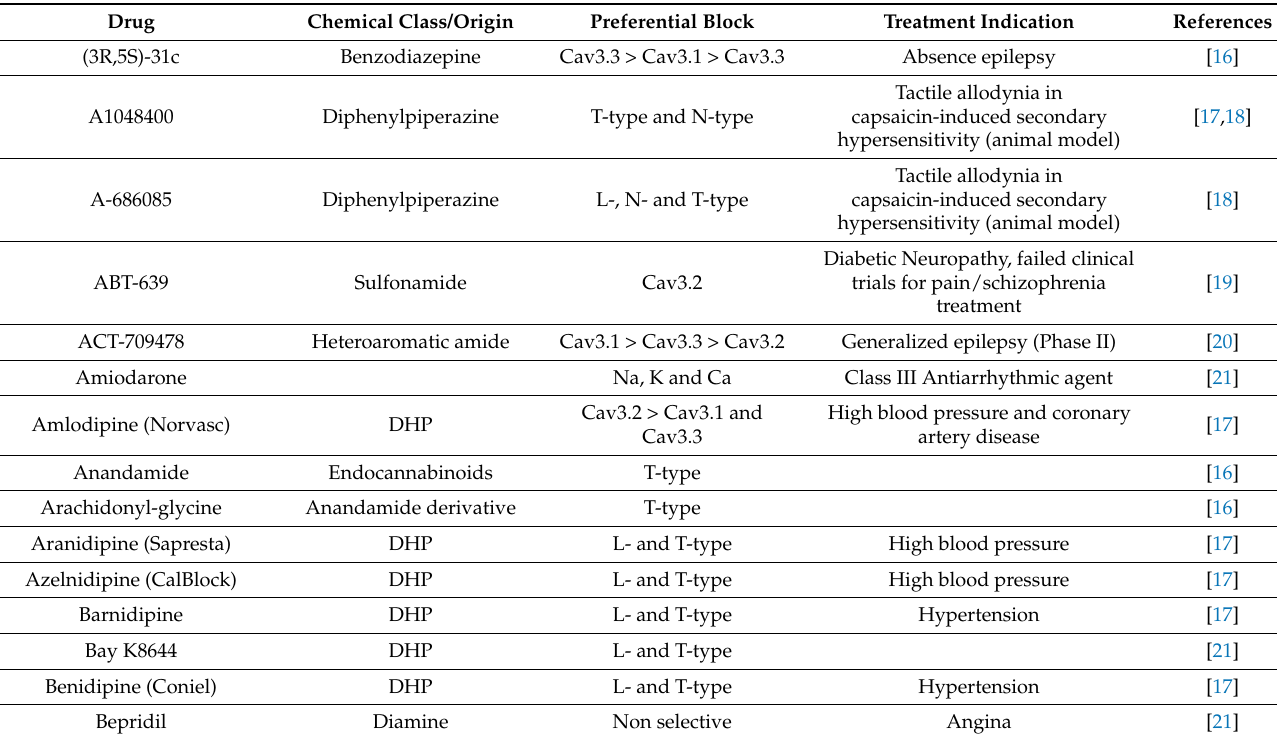
Table 1. T-type Ca 2+ channel